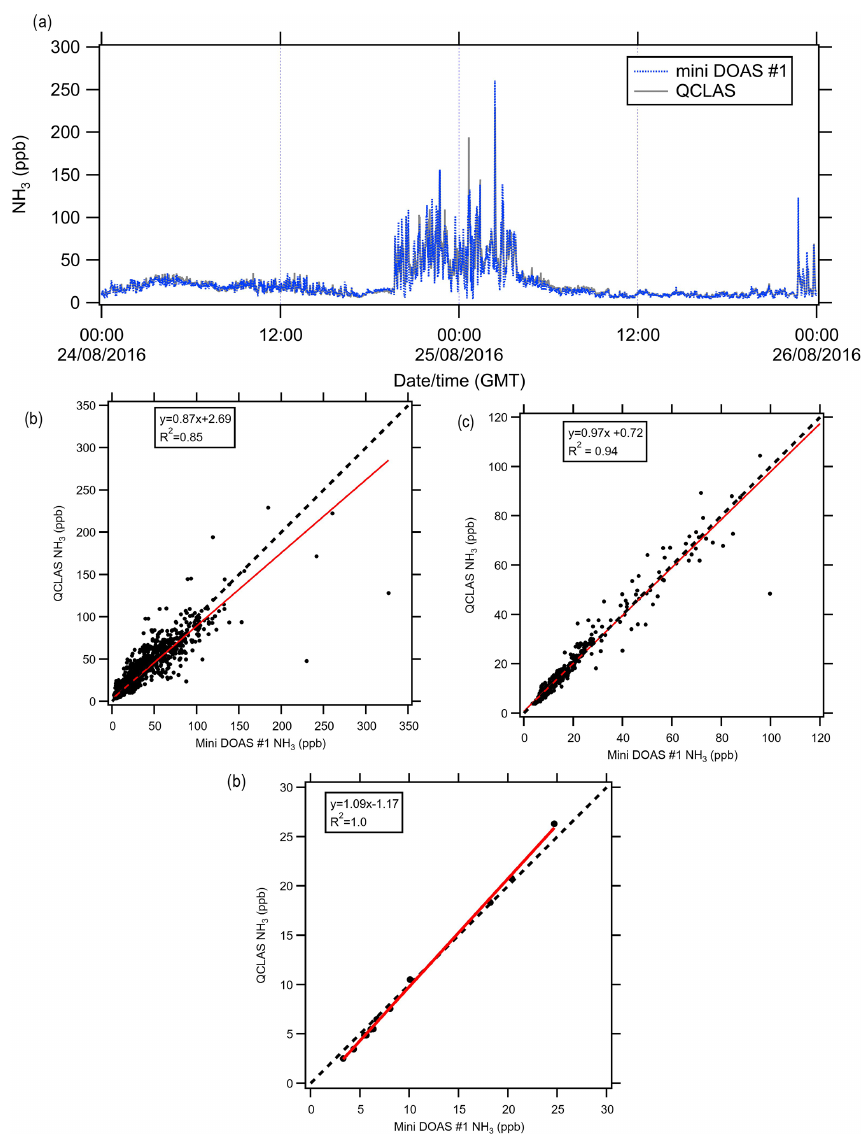
Figure 15. (a) Time series of mini-DOAS #1 vs QCLAS (1min averages) for the period 24 to 26 August 2016, (b) correlation of 1min averages, (c) regression plot for 10min averages, (d) 12h averages for the same